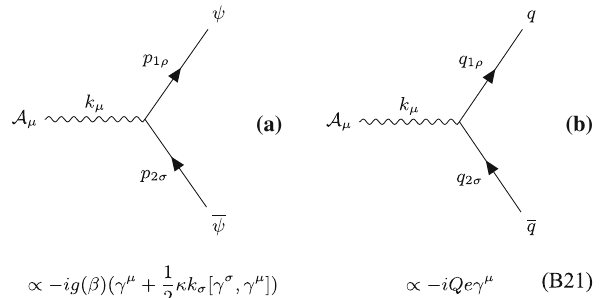
Fig. 32 a Spin- 1 / 2 fermionic monopoles interact with photons at the three-point vertex, where k σ is the photon momentum and g (β) is the magnetic coupling. b The quarks couple to the photon as expected form Dirac QED for spinors with fractional charges, Qe , where Q is the charge fraction relevant to the quarks involved, Q = 1 sponding Feynman rule is given in